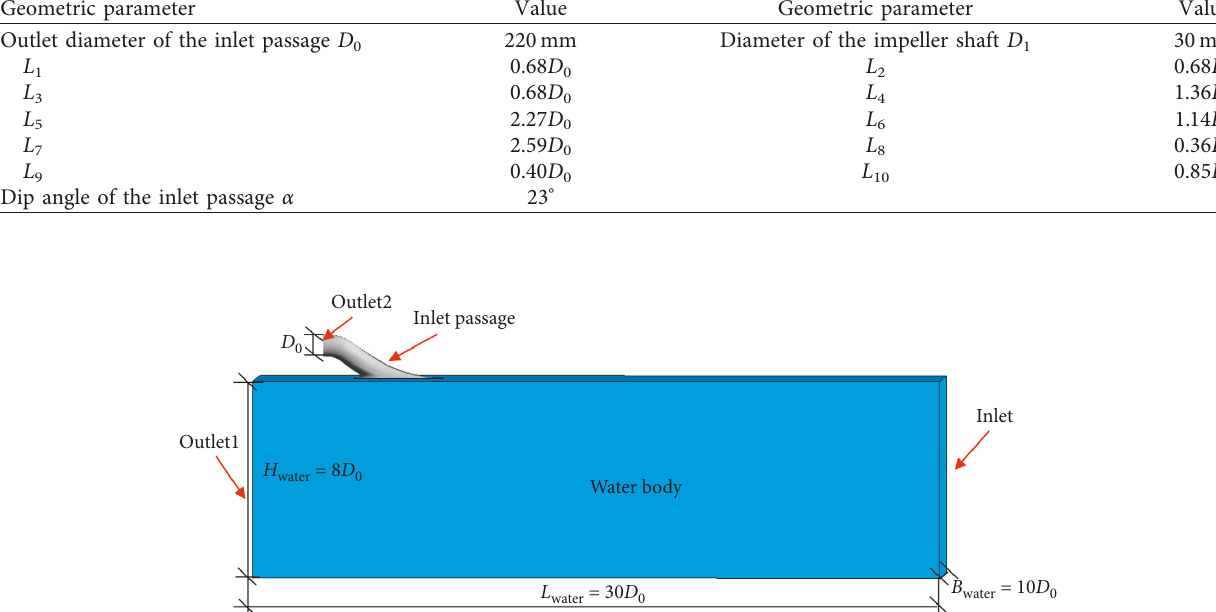
Figure 3: Computational domain.